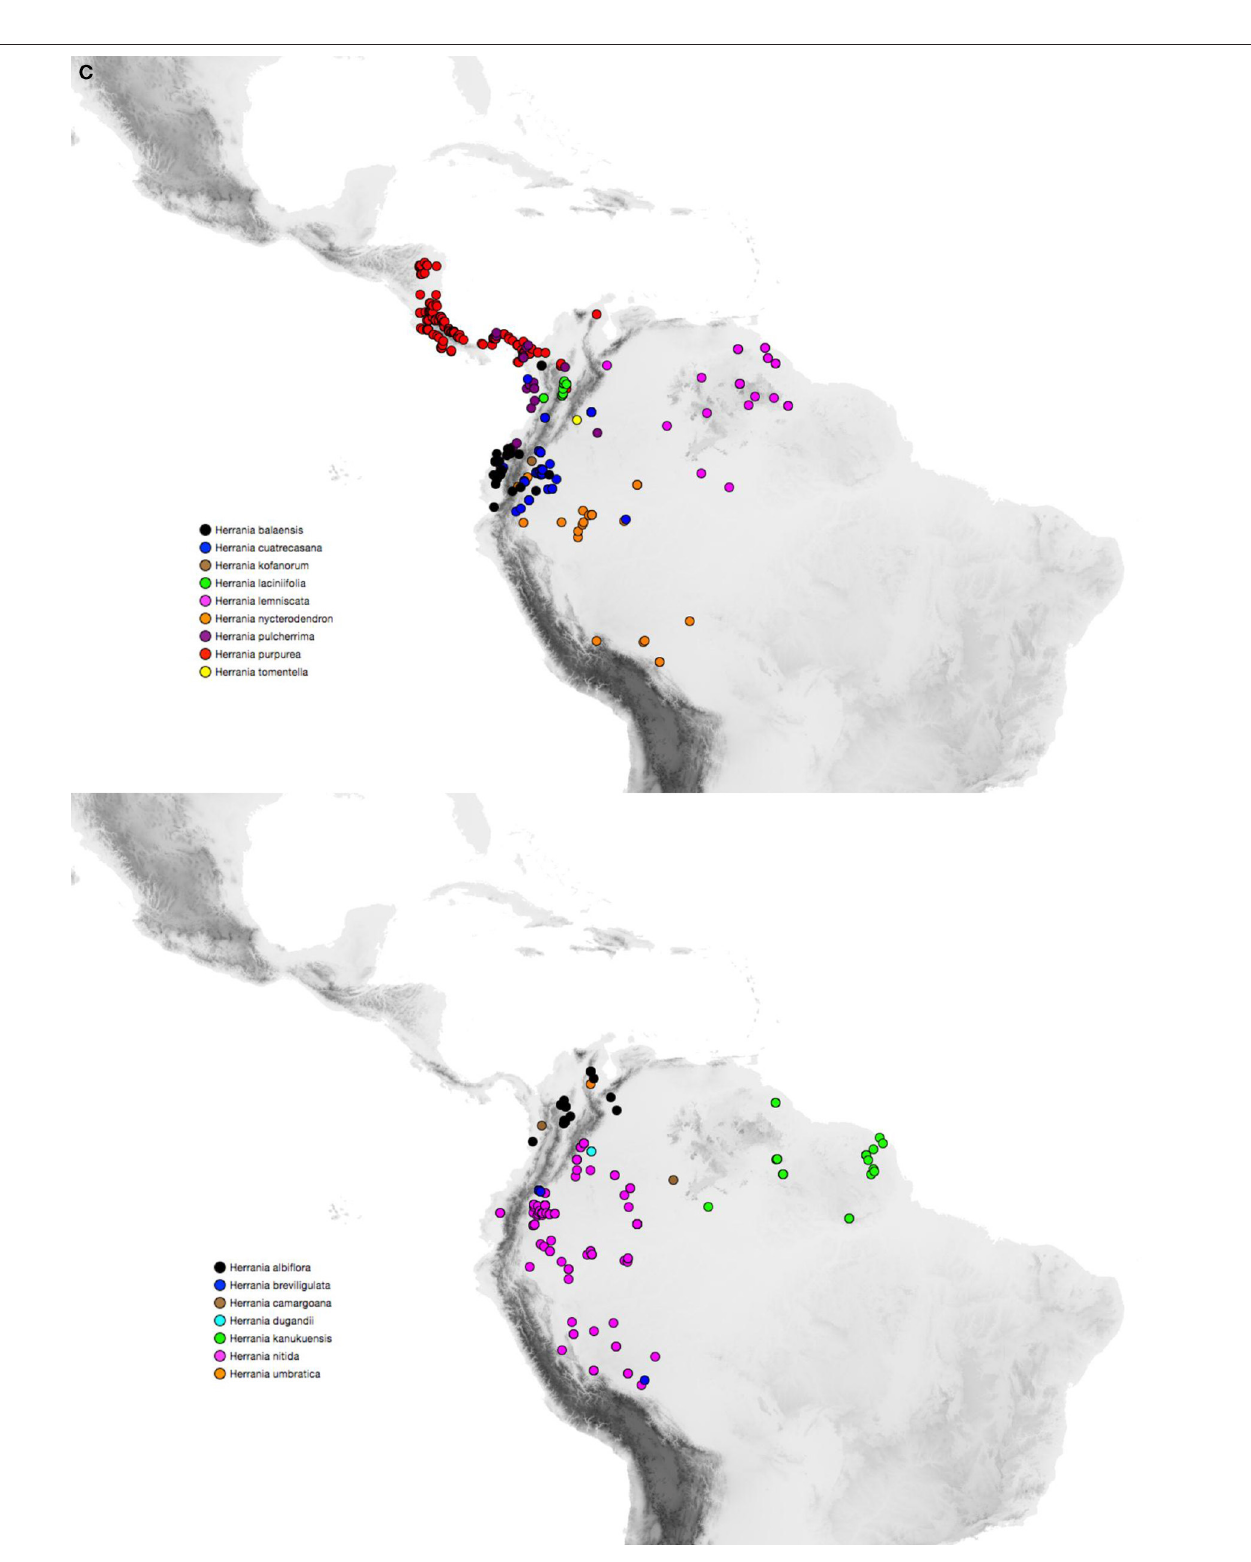
FIGURE 1 | (A-C) Maps indicating distributions of species of Theobroma and Herrania based on GBIF geo-referenced specimens and information from the original descriptions of species that are not found on GBIF. Theobroma cacao may contain some cultivated individuals.